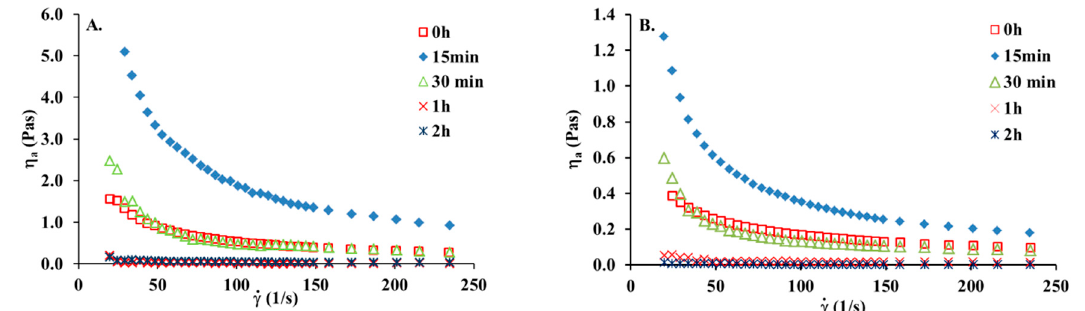
Figure 4. Viscosity curves of the collagen solutions: ( A ) 10 mg/mL, ( B ) 5 mg/mL at 20 °C before and after various times of UV irradiation.